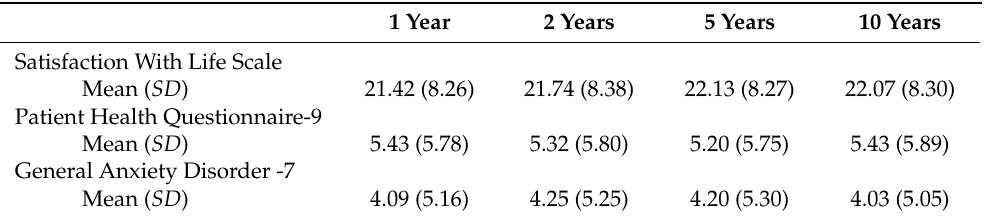
Table 2. Mental health variable means (SDs).